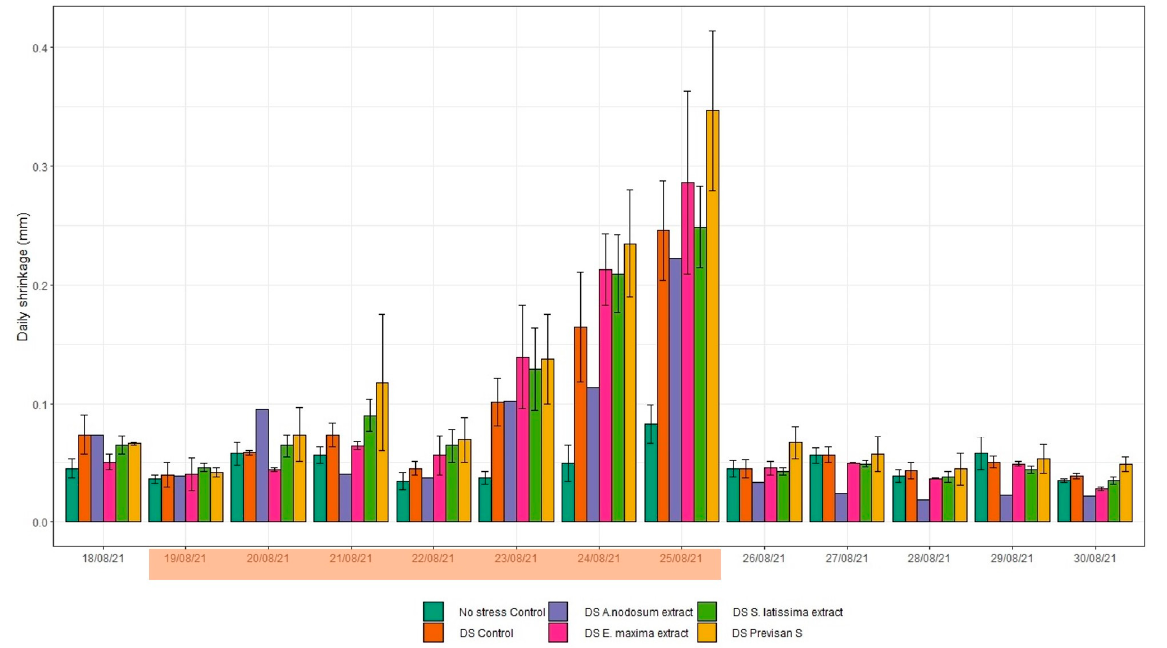
Figure 4. Effects of repeated drying cycles without (DS Control) and with biostimulant treatments on the daily stem shrinkage of Hydrangea before, during, and after the third drying cycle compared with optimal irrigation (No stress Control). Highlighted dates indicate stress period. (Mean ± SD (Standard Deviation)); n_No stress Control = 3, n_DS Control = 3, n_DS A. nodosum extract = 1, n_DS E. maxima extract = 2 , n_DS Previsan S = 2).